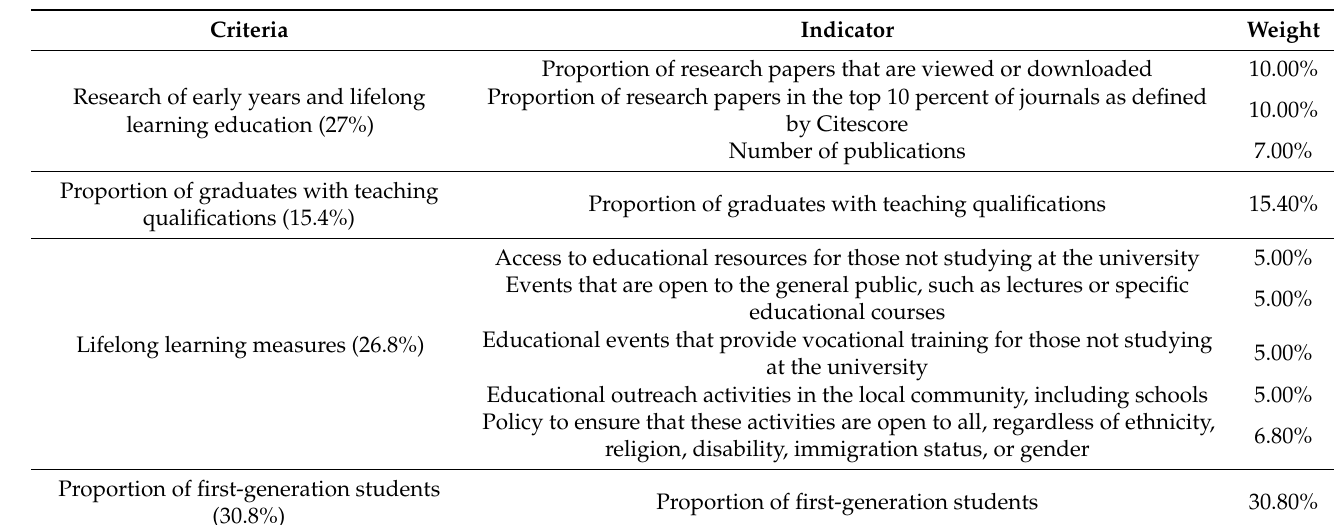
Table 3. Quality Education (SDG 4)